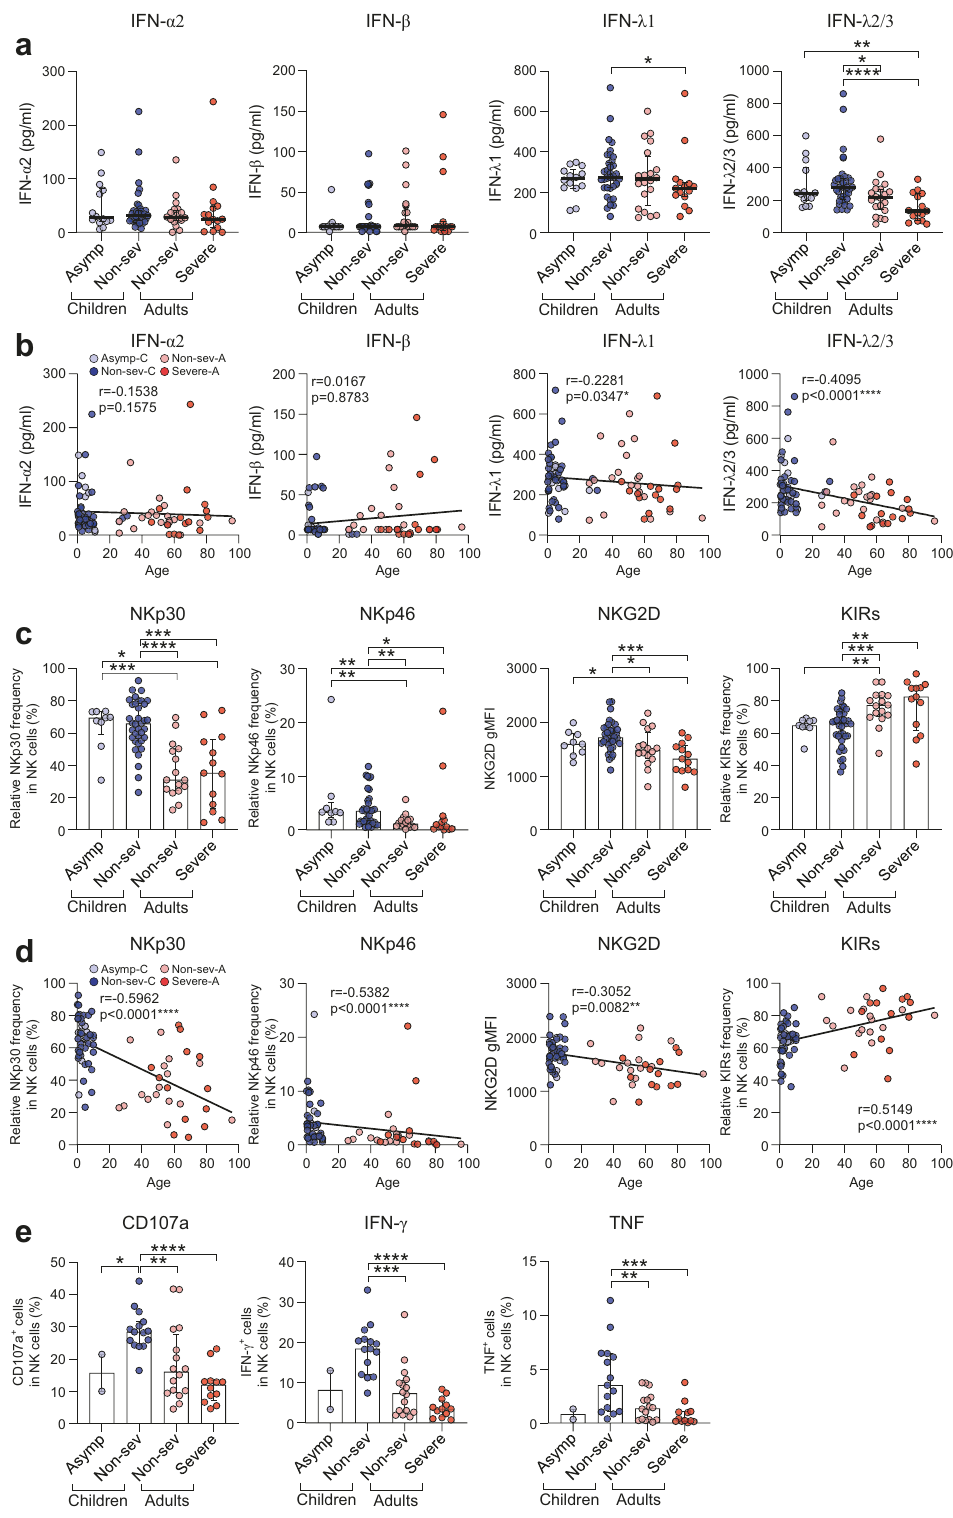
with K562 cells. As results, the non-severe children group exhibited higher NK cell functions than the non-severe and severe adult groups, including CD107a degranulation activity ( p = 0.005 or p < 0.0001) and the production of IFN- γ ( p = 0.0001 or p < 0.0001) and tumor necrosis factor (TNF) ( p = 0.008 or